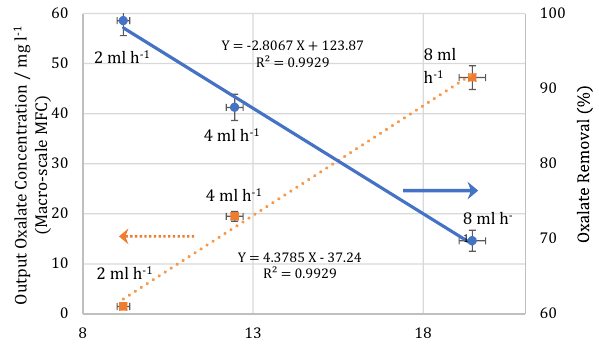
Figure 5. Measured Output oxalate concentration and oxalate removal versus maximum produced current density for macro-scale MFC. The error bars represent the variation of power and current densities among repeated